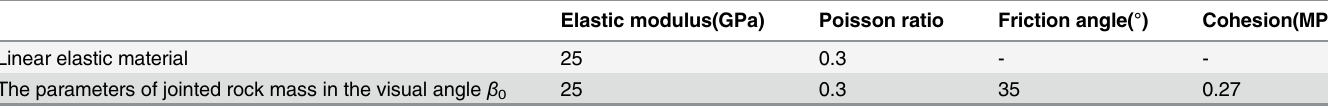
Table 3. The parameters of the rectangle foundation